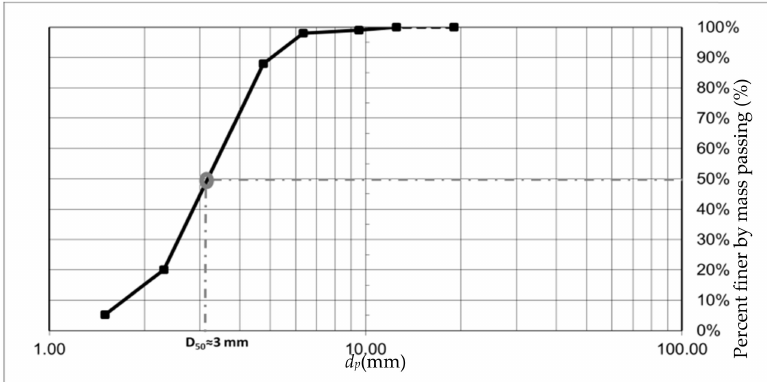
Figure 2. Grain size distribution of the bed material (the x -axis indicates the grain diameter; the y -axis indicates the percent of finer by mass